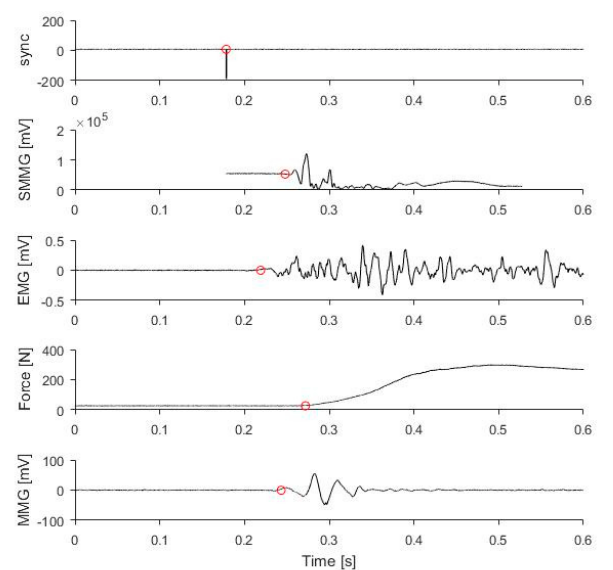
Figure 2. Onset detection in different signals. (Top to bottom) Synchronization signal, filtered ultrasound intensity variation in a pixel (SMMG), EMG, force, MMG signals plotted against time. The red circles mark the points of onset.